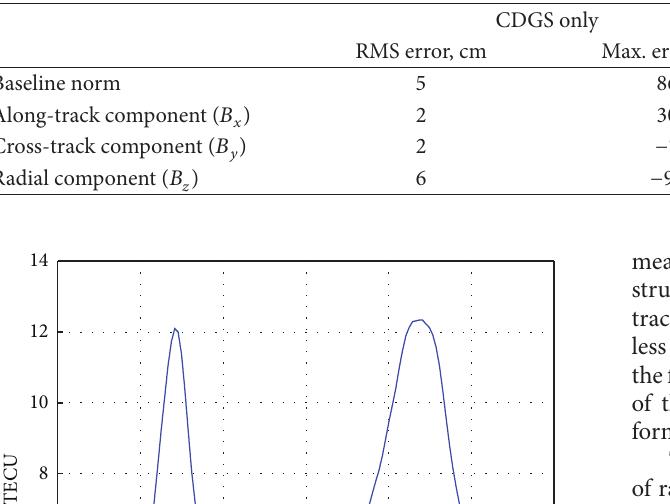
Figure 3: GDOP (a) and a number of common GPS satellites (b) for the selected single orbit scenario. Table 2: Performance statistics (the first case).